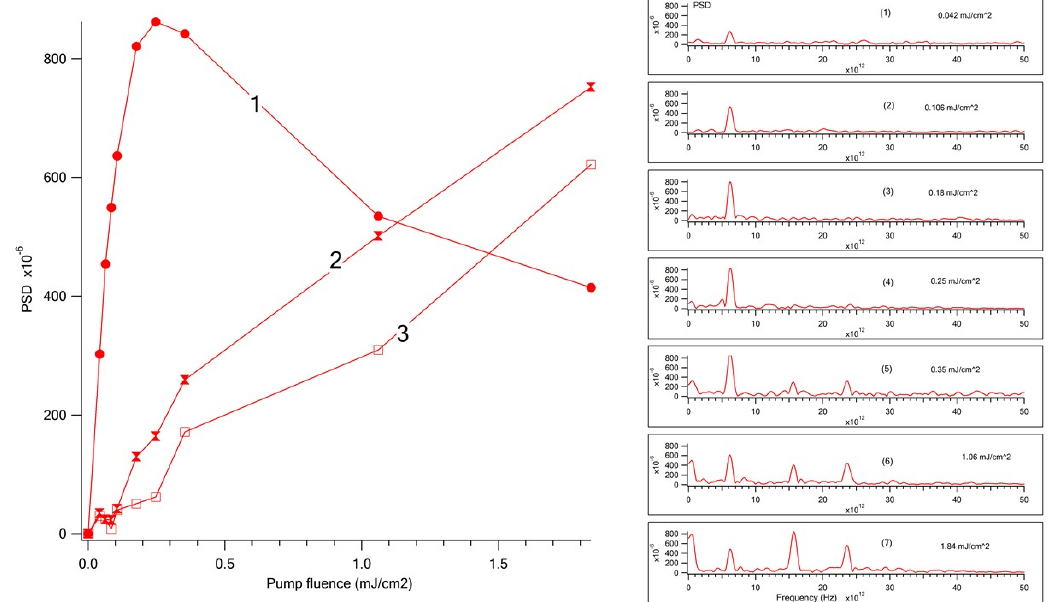
Figure 4. Dependence of the oscillation amplitude in transient traces at 567 nm on the pump fluence. ( Left ) 1. The oscillation amplitude of the coherent LO phonon at 6.16 THz; 2. The oscillation amplitude of the coherent longitudinal acoustic (LA) phonon at 0.55 THz; 3. The oscillation amplitude of the toluene wave packet at 15.6 THz. ( Right ) The dependence of PSD spectra, revealed by the FFT of oscillation components, on the pump fluence: (1) 0.042 mJ/cm 2 ; (2) 0.106 mJ/cm 2 , (3) 0.18 mJ/cm 2 , (4) 0.25 mJ/cm 2 , (5) 0.35 mJ/cm 2 , (6) 1.06 mJ/cm 2 , (7) 1.84 mJ/cm 2 .